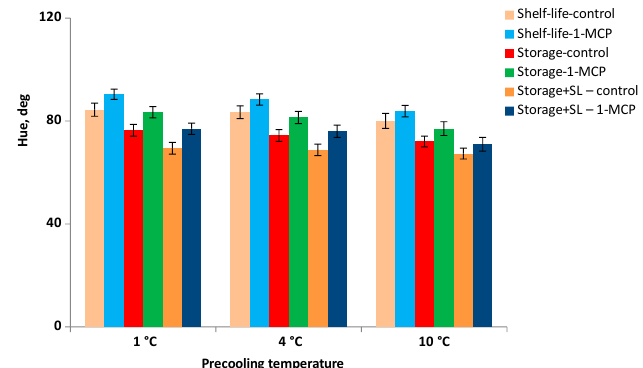
Fig. 5: Hue angle value during experiment (SL: shelf-life). Presented values are means ± SD.